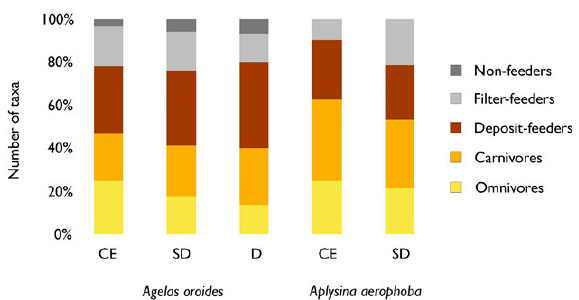
Fig. 8. – Trophic structure, in terms of number of taxa, of sponge- associated polychaetes and crustaceans across the surveyed caves (CE, entrance; SD, semidark zone; D, dark zone).